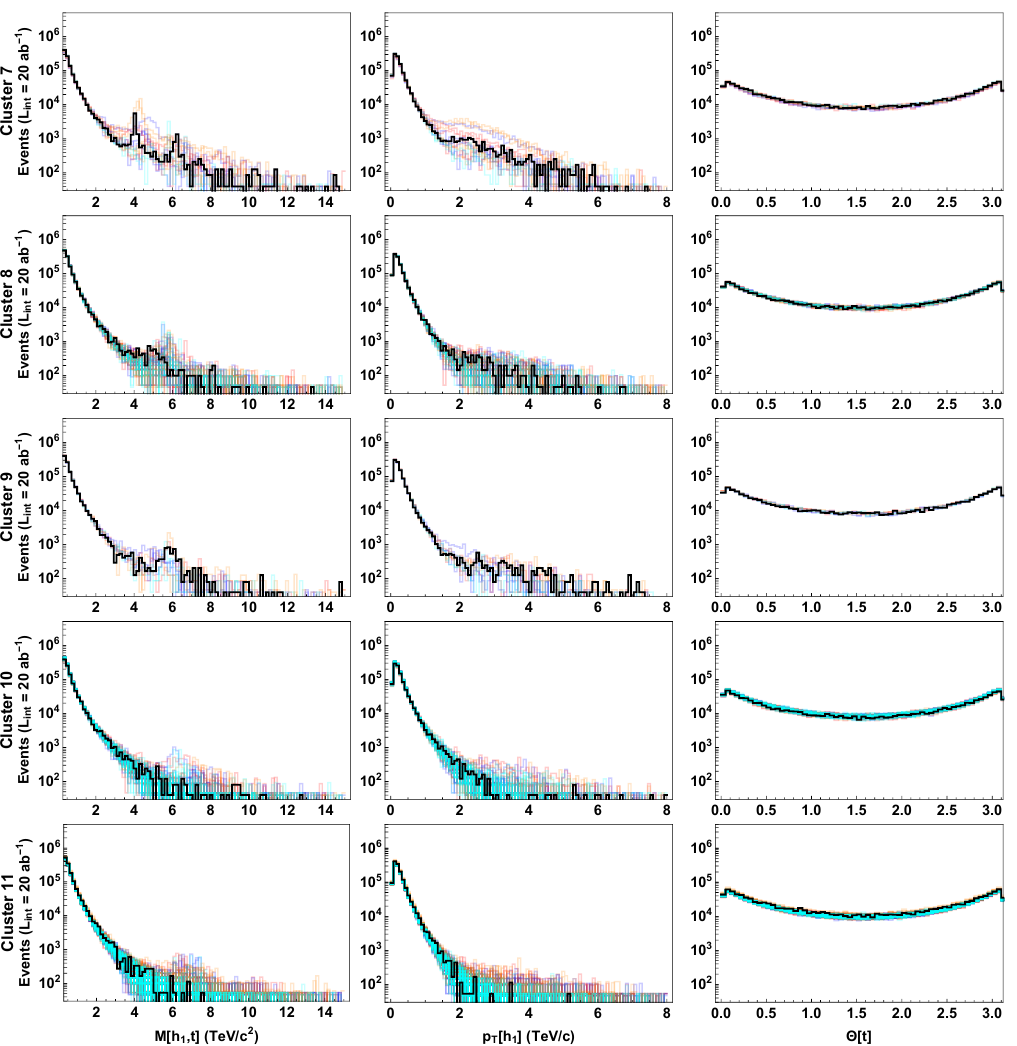
√ Figure 27 . Distributions at s = 100 TeV for the invariant mass of the pair composed by top and most energetic Higgs h 1 (first column), transverse momenta of h 1 (second column) and the top angle (third column), organized in clusters by similarity (clusters 7 through 11). Red, blue, orange and cyan curves indicate respectively points in Regions I, II, III and IV of the MCHM 14 . The benchmark point for each cluster is shown in black, with clusters 1 to 6 containing respectively points F 7 to F 11 in table 8 of the main